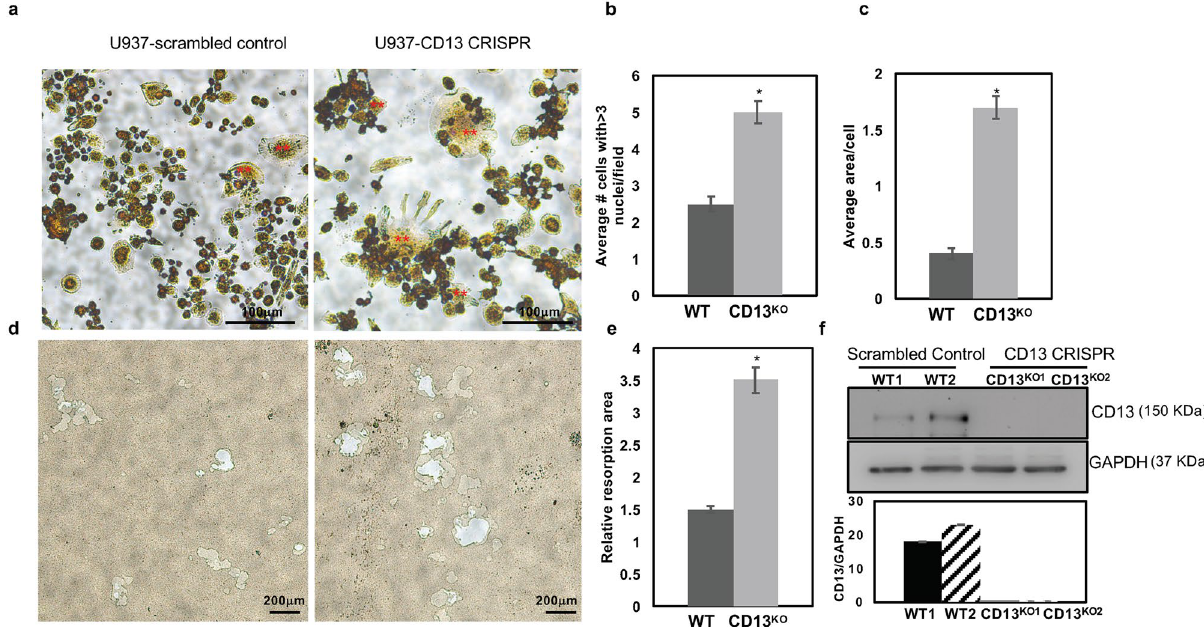
Figure 5. Increased Multinucleated OC formation in U937 cells expressing CD13 CRISPR. ( a ). TRAP staining of U937 expressing scrambled control or CD13 CRISPR grown in presence of PMA for 3 days followed by M-CSF and RANKL for 10 d indicated increased size and number of multinucleated OCs in absence of CD13 compared to WT. ( b ) Multinucleated OC (**) with greater than 3 nuclei per cell and ( c ), average area of OC. ( d ). Phase contrast imaging of area of resorption in U937 cells expressing CD13 CRISPR or scrambled control grown in presence of PMA followed by M-CSF and RANKL for 17 d on osteoplates. TRAP + osteoclasts were imaged with Zeiss fluorescence inverted microscope and analyzed by using Zeiss Zen 2.0 Pro blue edition software (https:// www. zeiss. com/ conte nt/ dam/ Micro scopy/ Downl oads/ Pdf/ FAQs/ zen2- blue- editi on_ insta llati on- guide. pdf). Area of resorption was imaged using a light microscope (Olympus Scientific), using Olympus cellSens Dimension V0118 software (Olympus Scientific) (https:// www. olymp us- lifes cience. com/ en/ softw are/ cells ens/) quantified by Image J (https:// imagej. nih. gov/ ij/) ( e ). ( f ). Immunoblot analysis of CD13 expression in U937 cells expressing CD13 CRISPR or scrambled control clones. Blots were imaged by ChemiDoc Imaging system version 3.0.1 (https:// www. bio- rad. com/ en- us/ categ ory/ chemi doc- imagi ng- syste ms? ID= NINJ0 Z15) (Biorad). A cropped image is shown, see Supplementary Fig. S6 for full-length blots and cropped